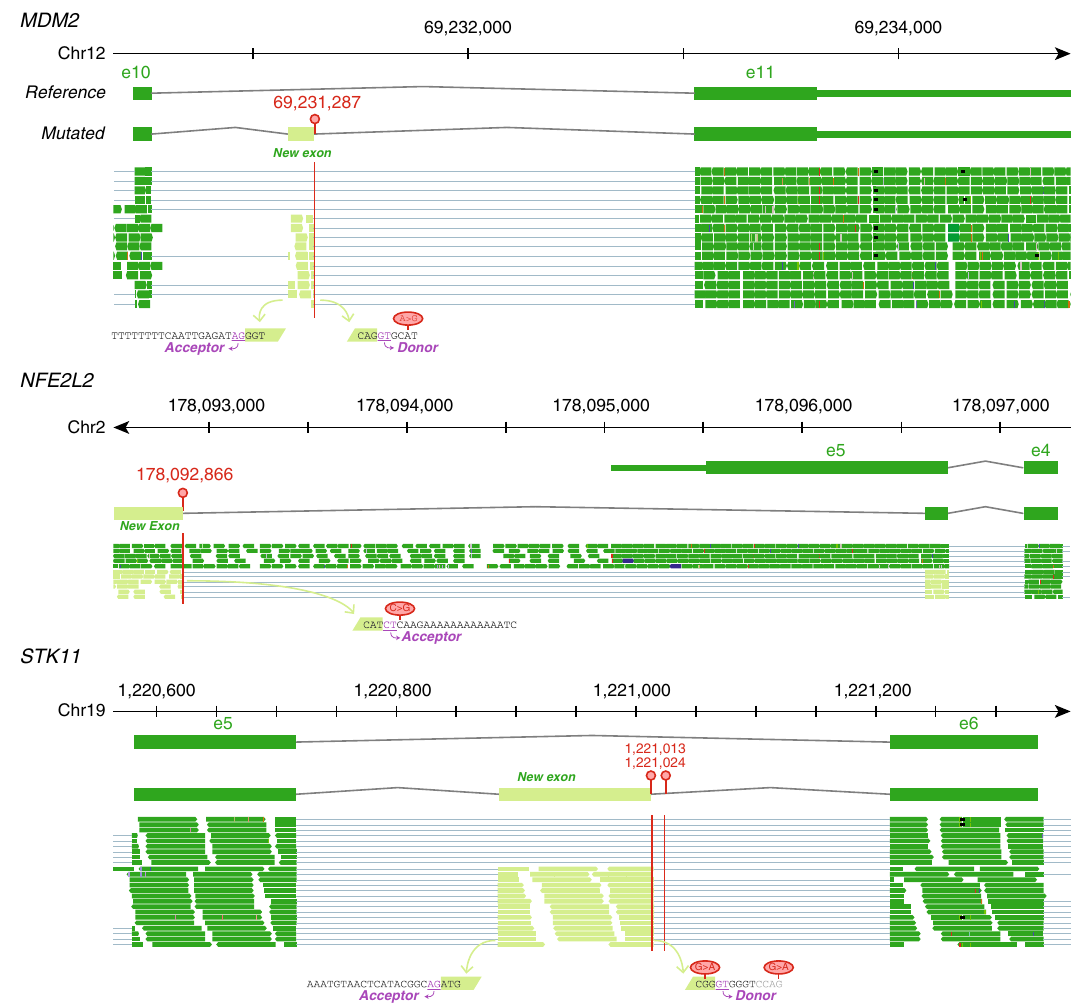
Fig. 4 IGV schematics of MDM2 , NFE2L2 , and STK11 splicing patterns. Sequence reads visualized in IGV supporting the junctions of exon-creating events for MDM2 , NFE2L2 , and STK11 . Red vertical lines indicate mutation positions. Source data are provided as a Source Data fi